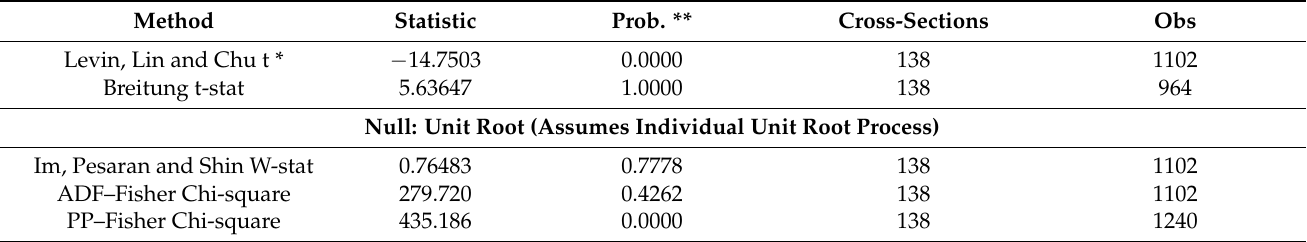
Table 2. Panel unit root test for GOV_AVG time